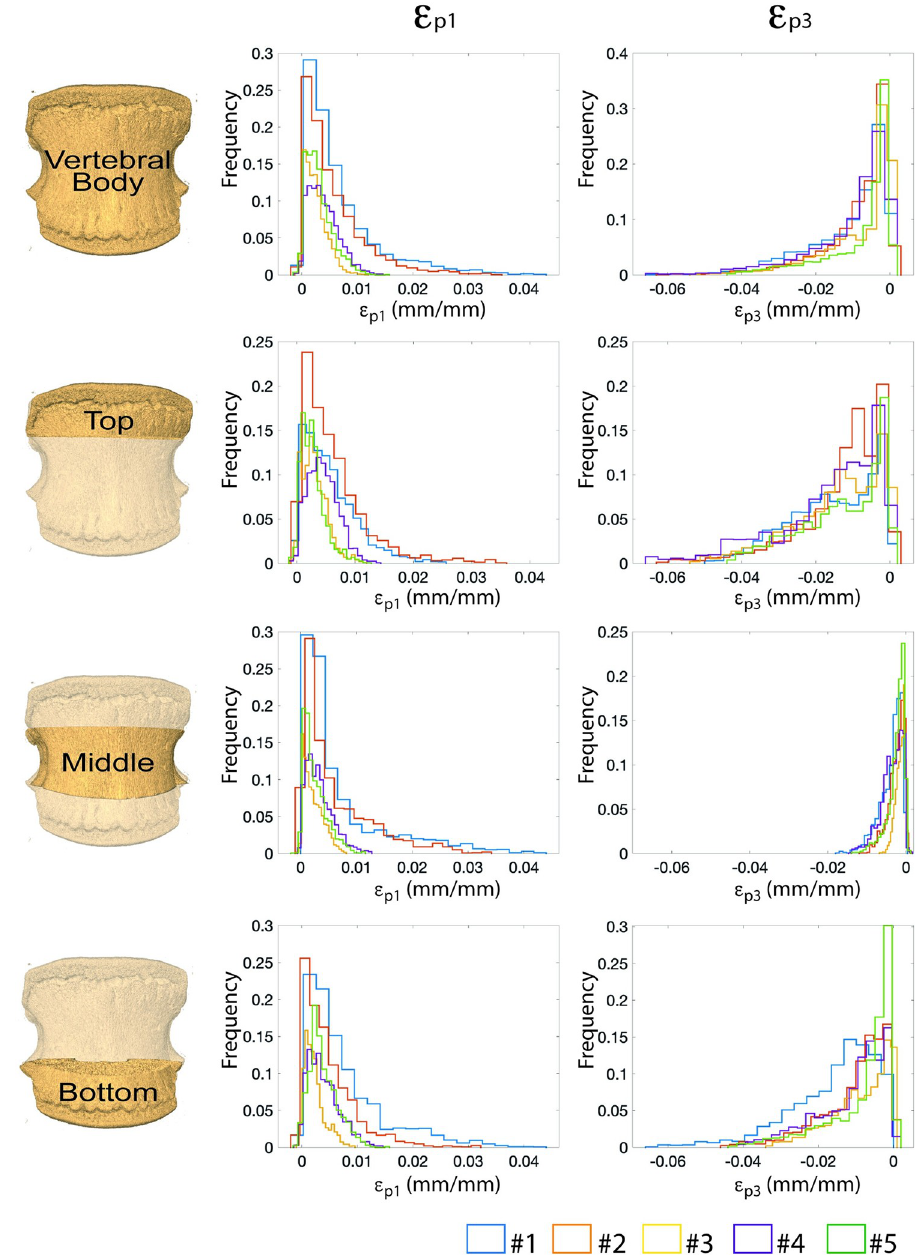
Fig 3. Frequency plot for the ε p1 and ε p3 evaluated for each intact specimen for the entire vertebra, for the top, middle and bottom ROIs. The distributions of ε (Fig 4) within the intact vertebral bodies showed similar patterns p3 with larger deformations ( ε < -2%) localized in correspondence of the top and bottom ROIs, p3 that include the growth plates, and quite uniform strains ( ε of approximately -0.25%) in the p3 middle of the vertebral body. While the ε over the vertebral body reached peaks of approxi- p3 mately -6%, localised in the top or bottom ROIs, the peak deformation in the middle ROI was lower (approximately -1.8%) (Fig 5).